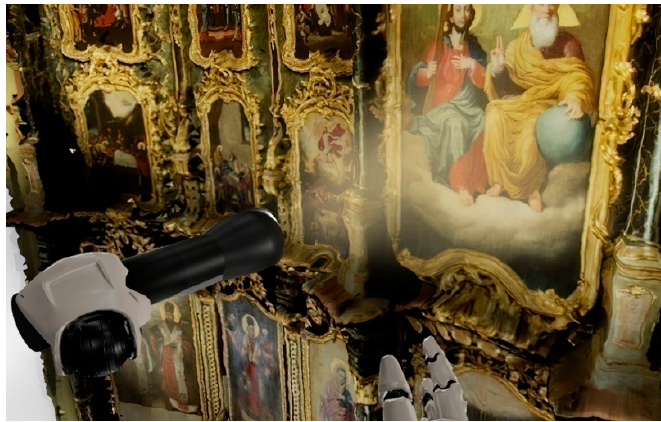
Figure 12. Using the interactive flashlight.